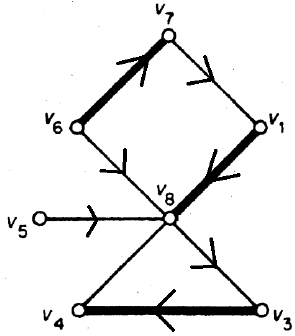
Figure 4: A matching for a